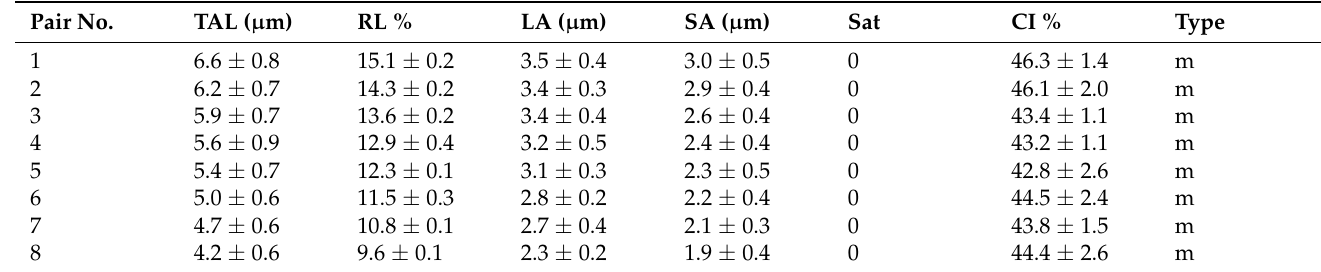
Table 2. Karyo-morphometric parameters of A. pallasii accessions in µ m.